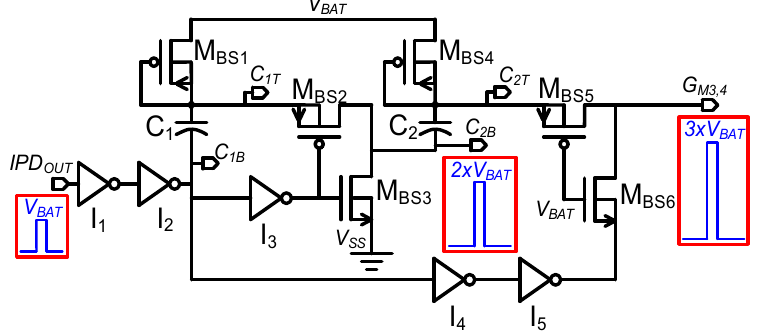
Figure 11. Two-stage bootstrap driver